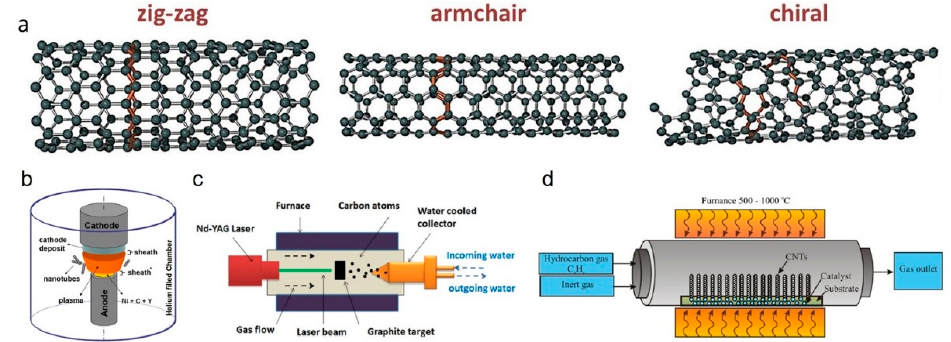
Figure 11. ( a ) Single-walled carbon nanotubes (SWCNTs) configuration [145]. Three common systems for carbon nanotube (CNT) synthesis: ( b ) arc-discharge [146], ( c ) laser ablation [147] and ( d ) thermal